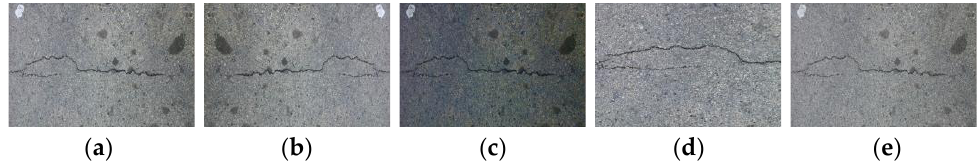
Figure 10. Visual comparison results of different algorithms in crack images with noise. ( a ) Road Image with Noise; ( b ) Ground Truth; ( c ) DeepCrack; ( d ) SegNet; ( e ) Fast-SCNN; ( f ) Ours.